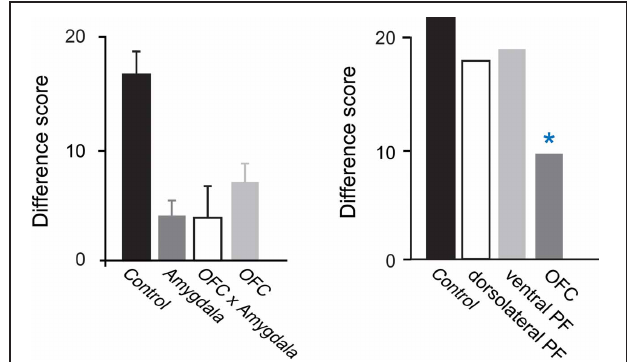
FIGURE 2 | Devaluation effects for object–outcome associations. Summary of the scores of several groups of monkeys studied using the devaluation task. The scores for each group are reflected in a single bar; a higher score indicates greater sensitivity to changes in food value. Intact monkeys avoid choosing objects associated with a devalued food, as indicated by the high difference scores obtained by the unoperated control group. In the left panel , monkeys with bilateral lesions of either OFC or the amygdala continue to choose much like they had before the selective satiation procedure, as reflected in the low difference scores. In addition, monkeys with a surgical disconnection that prevents the intrahemispheric interaction of the amygdala and OFC cannot efficiently link objects with the current value of a food reward. Although the operated groups were subjects in different studies, all groups were tested in a similar fashion and had similar experimental histories. In the right panel , scores of groups with lesions in different sectors of prefrontal cortex are provided. ∗ p < 0 . 05. Data in left panel are from Baxter et al. (2000), Izquierdo et al. (2004), and Izquierdo and Murray (2007). Data in the right panel are from Baxter et al. (2008, 2009). Modified from Murray and Wise (2010). Abbreviations: Control, unoperated control monkeys; Amygdala, monkeys with bilateral excitotoxic amygdala lesions; OFC, monkeys with bilateral aspiration lesions of the orbital prefrontal cortex; OFC × Amygdala, monkeys with surgical crossed disconnection of the amygdala and OFC; dorsolateral PF, monkeys with bilateral aspiration lesions of the dorsolateral prefrontal cortex; ventral PF, monkeys with bilateral aspiration lesions of the ventral prefrontal